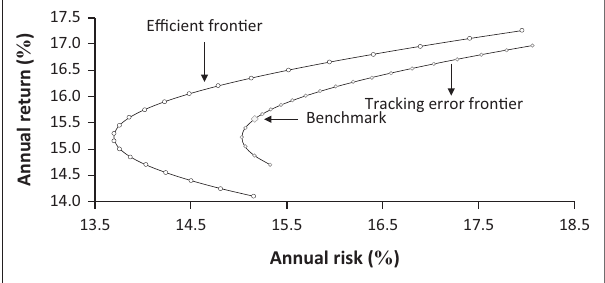
FIGURE 1: Efficient frontier and tracking error frontier in mean–standard deviation space. The diamond marker indicates the benchmark on the tracking error